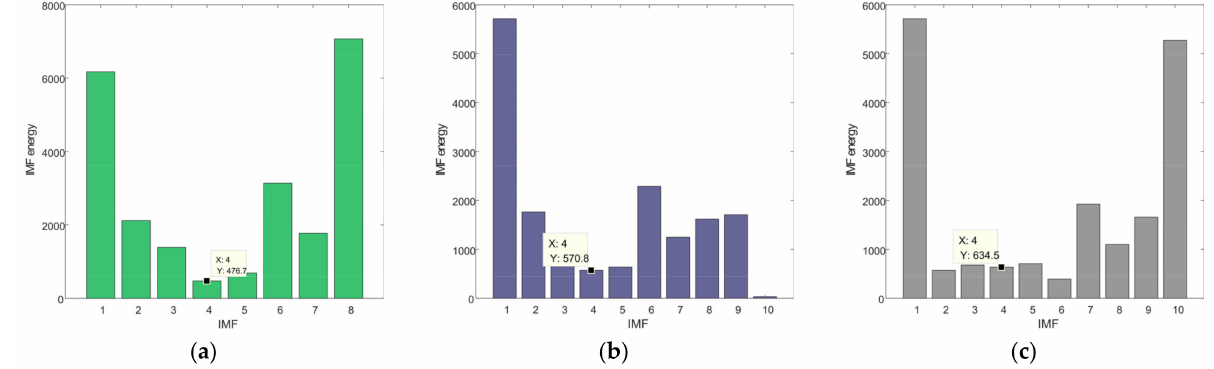
Figure 8. IMF energy per order for the simulated signal: ( a ) EMD; ( b ) EEMD; ( c ) CEEMD.